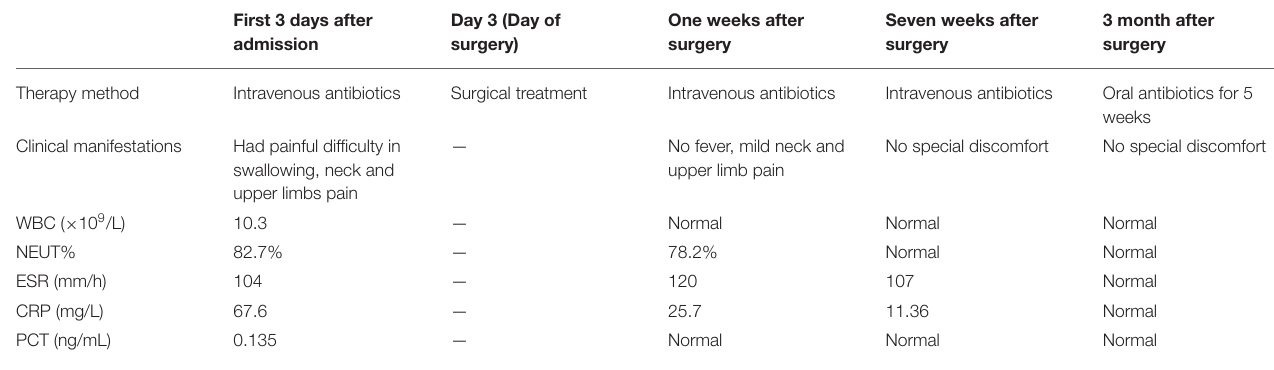
TABLE 1 | Patient treatment timeline and relevant main clinical